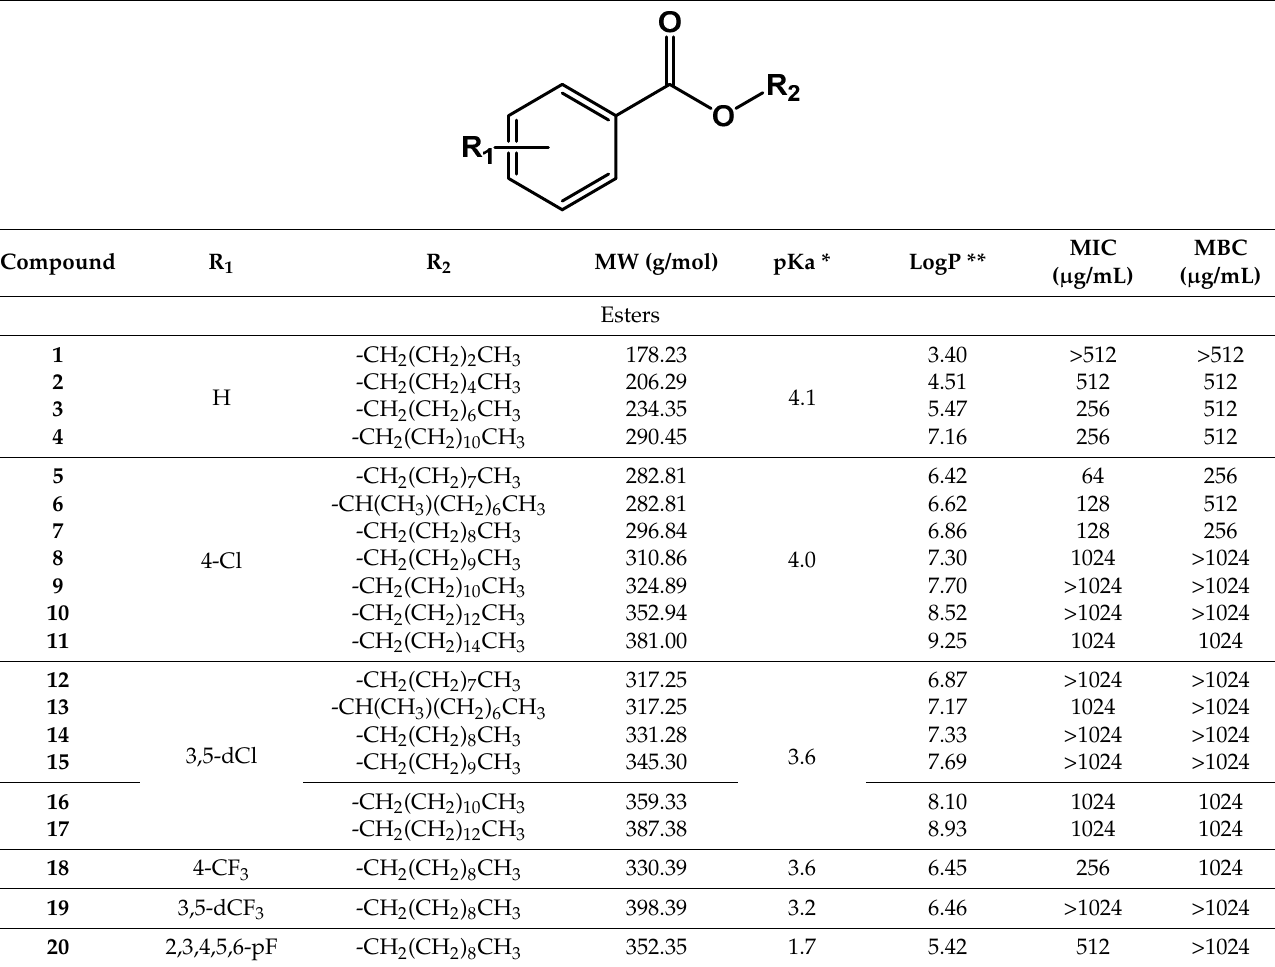
Table 1. Structure, physical properties and antitubercular activity of benzoate esters against Mtb H37Rv.